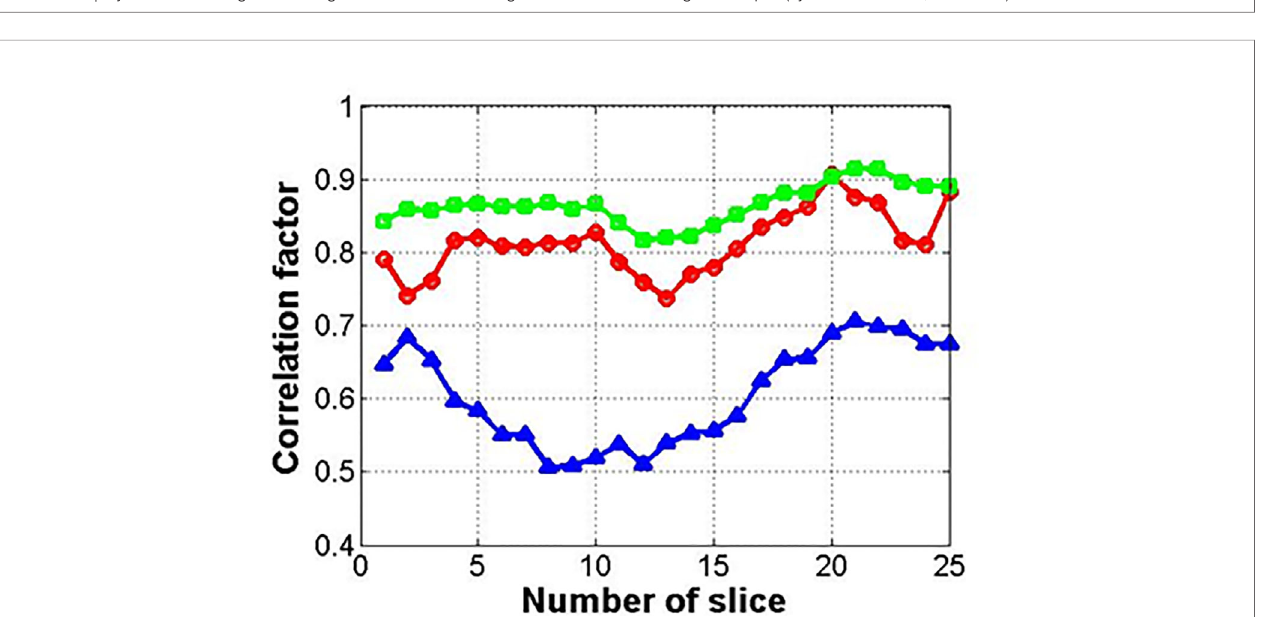
FIGURE 6 | Synthetic MR images from original 0.06 Tesla and original 1.5 Tesla MR images in step 2 (cyclic-GAN model, method 3).